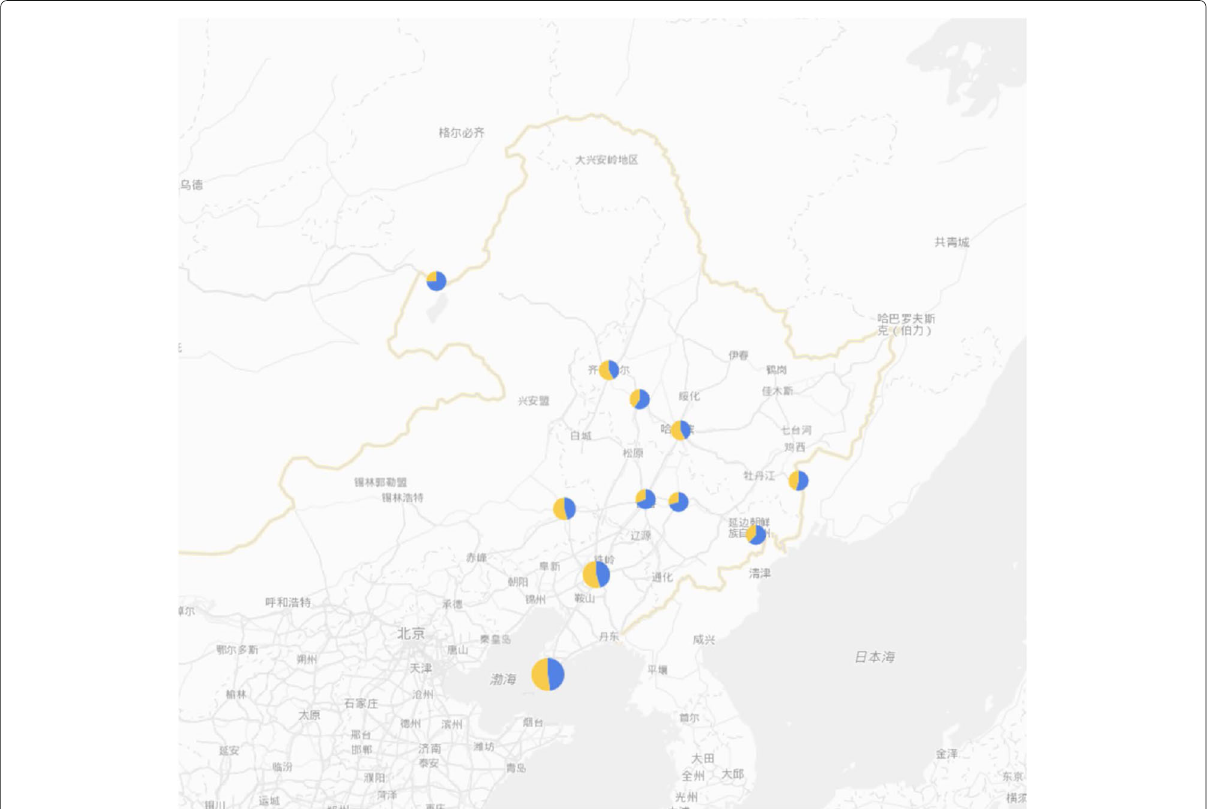
Fig. 3 Quantity of import and export containers. Yellow: export; Blue: import; Size: quantity